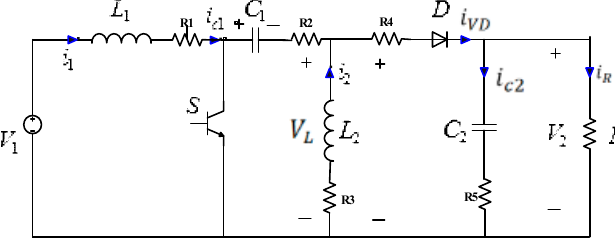
Figure 5. The equivalent circuit of the SEPIC module.